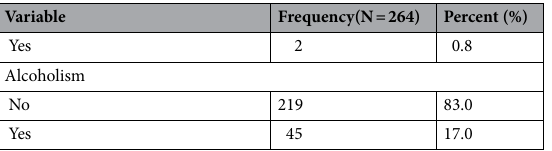
Table 1. Socio-demographic and patient characteristics of 264 participants recruited in the study. SD is standard deviation.